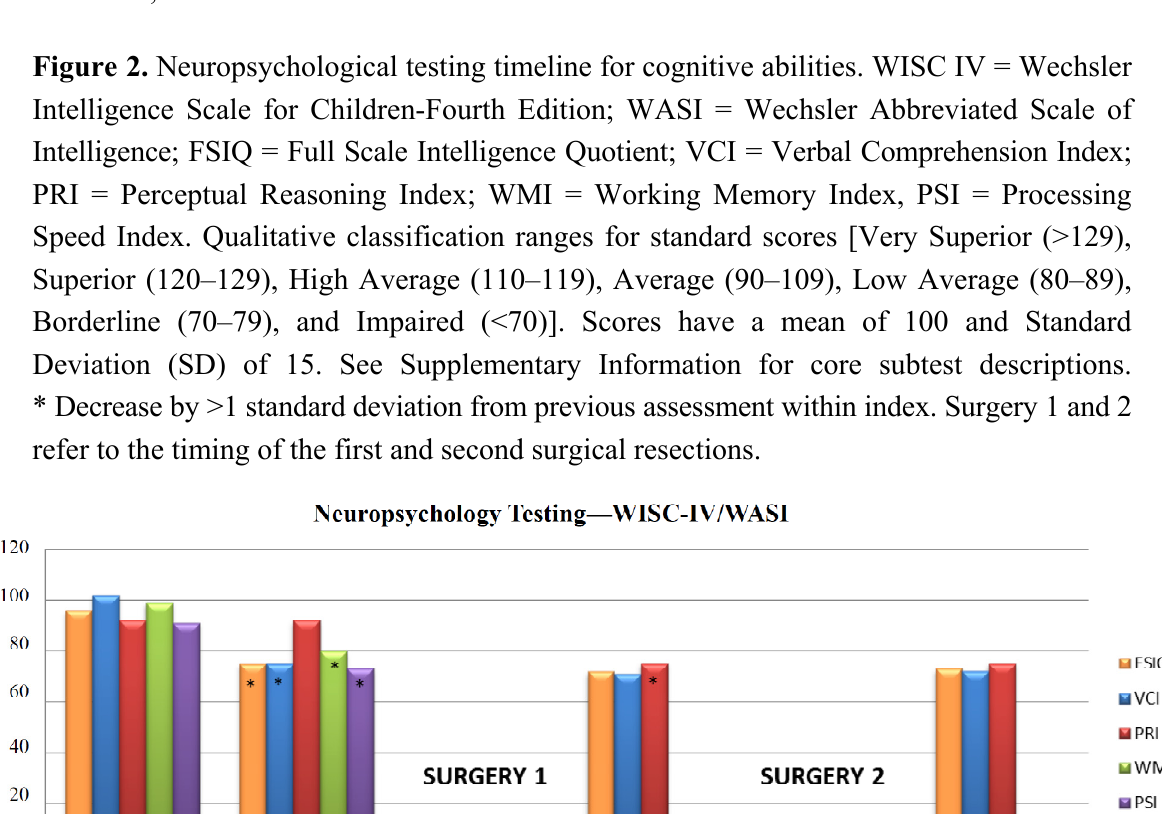
Figure 2. Neuropsychological testing timeline for cognitive abilities. WISC IV = Wechsler Intelligence Scale for Children-Fourth Edition; WASI = Wechsler Abbreviated Scale of Intelligence; FSIQ = Full Scale Intelligence Quotient; VCI = Verbal Comprehension Index;